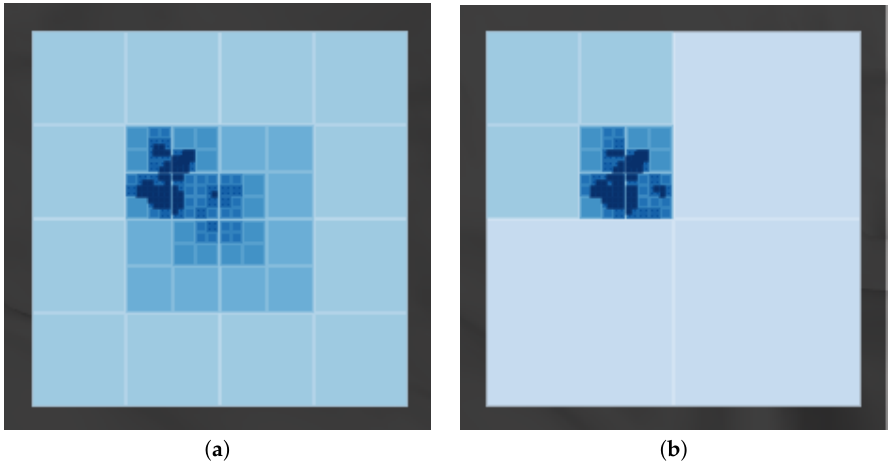
Figure 11. Visualization of the depth in 2D for 50,000 particles: ( a ) with no friction coefficients; and ( b ) with friction coefficients.